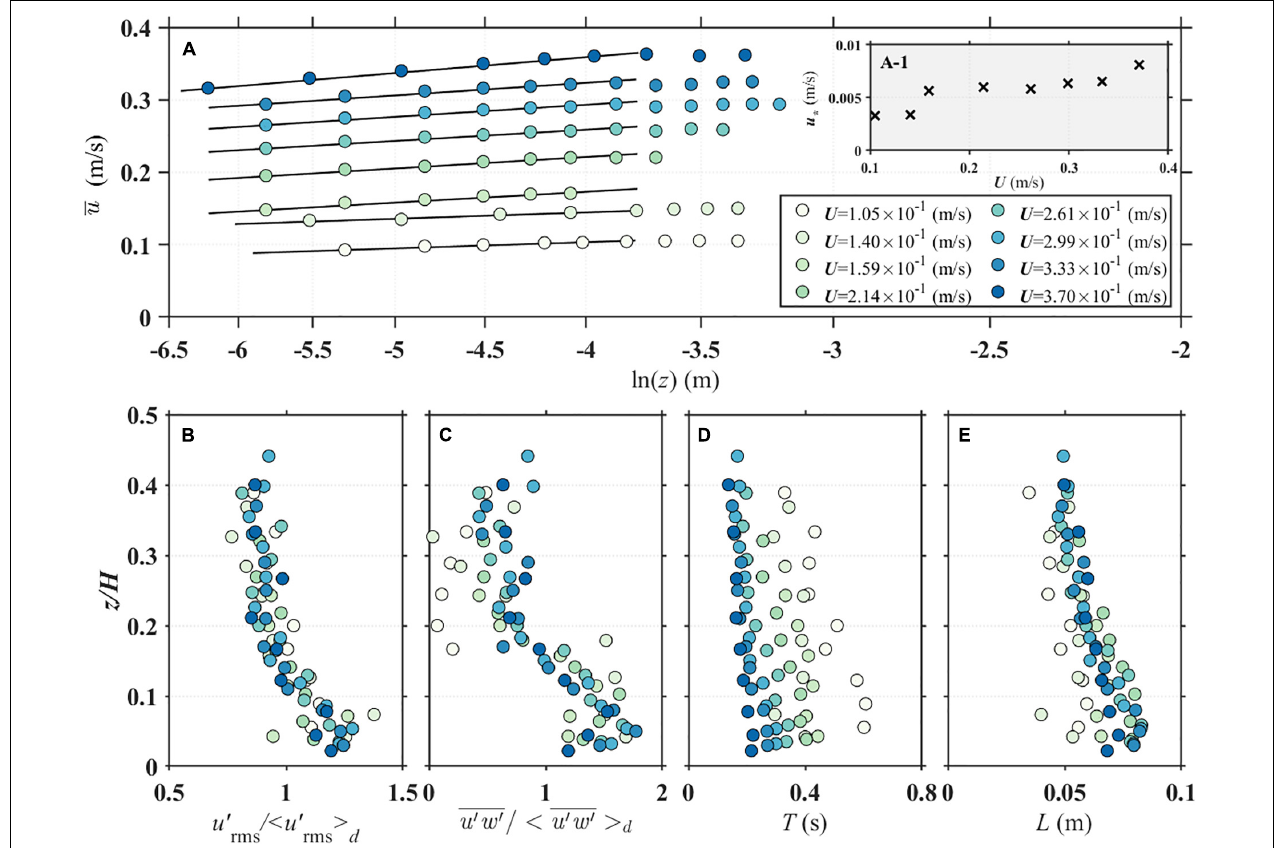
FIGURE 4 | Vertical profiles of the (A) temporal averaged stream-wise velocity, (B) stream-wise turbulence intensity, (C) Reynolds shear stress, (D) integral time scale, and (E) integral length